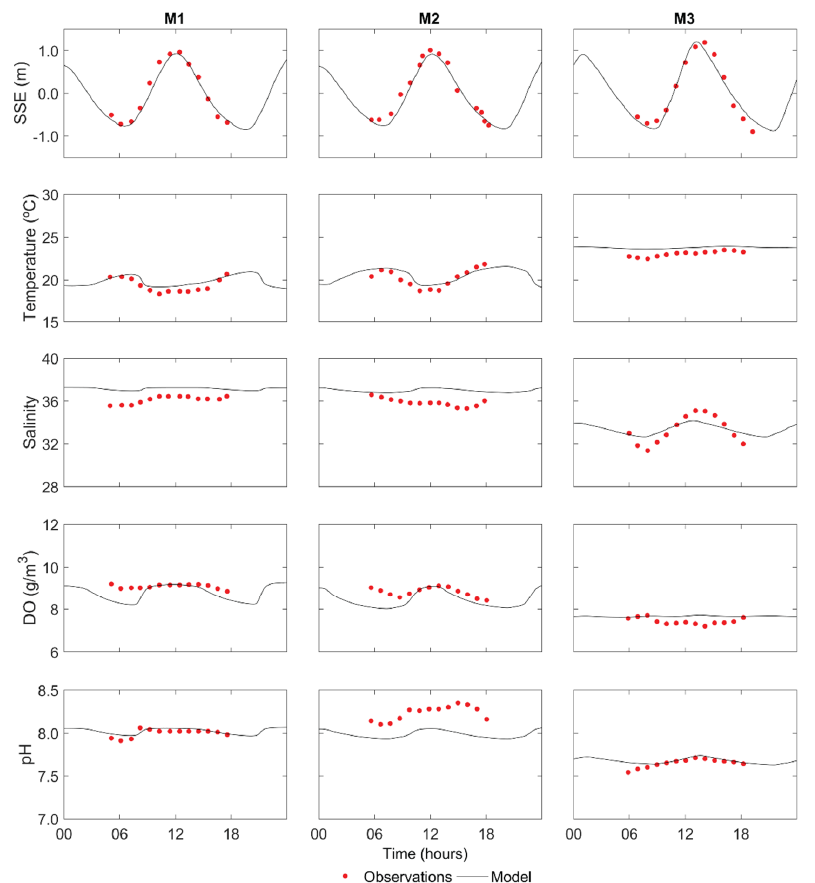
Figure 2. Observed and predicted sea surface elevation (SSE), water temperature, salinity, dissolved oxygen (DO) and pH for M1, M2, and M3 stations located at Mira Estuary on 25 th (M1 and M2) and 26 th (M3) September 2019. Table 2. Root mean square error (RMSE) for Mira estuary (M1, M2, M3) and Ria de Alvor (A1, A2) stations.